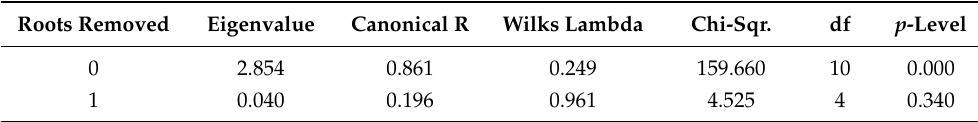
Figure 4. Sampled soil spectra represented as a function of discriminant factors (roots) 1 and 2. Samples are labeled according to the fire severity treatments. Abbreviations: moderate fire severity (MS); high fire severity (HS). Table 5. Chi-Square Tests with Successive Roots Removed.